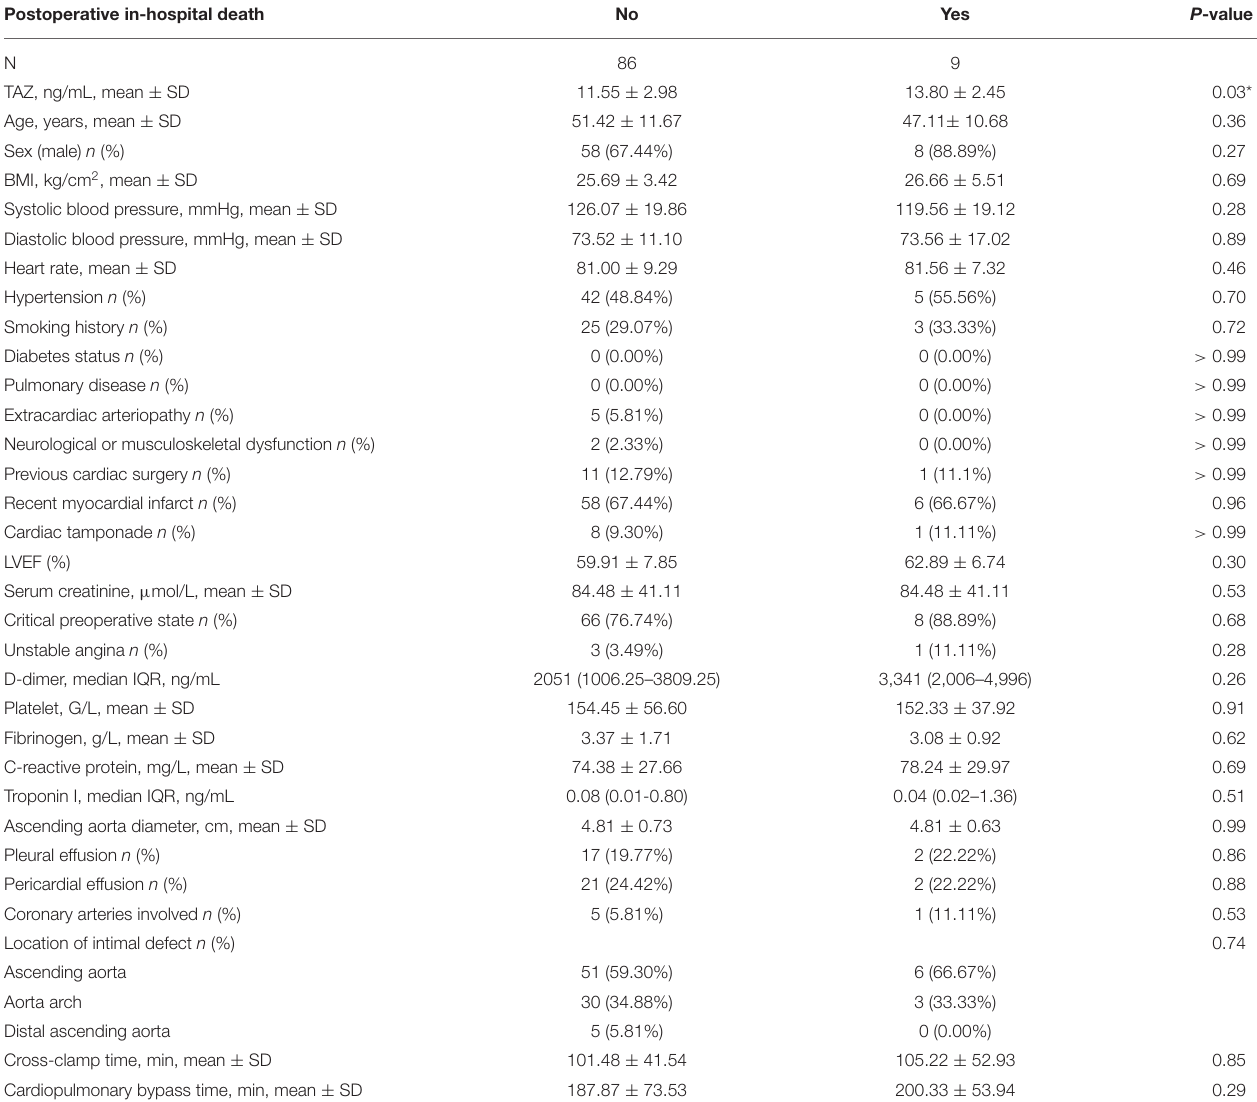
TABLE 1 | Baseline characteristics of participants in